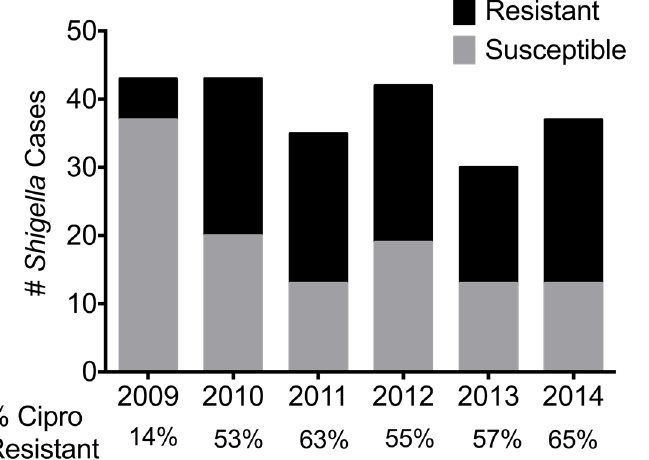
Figure 2. Shigella susceptibility by year Table 2. Shigella species by susceptibility